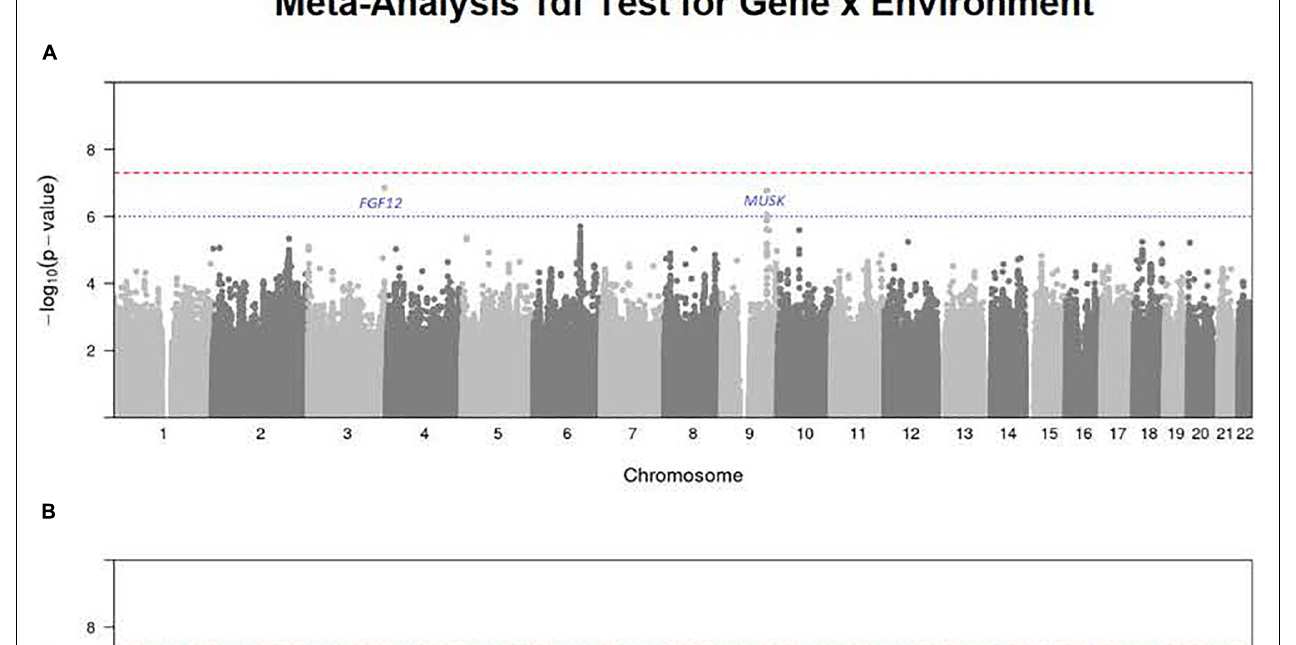
FIGURE 3 | Manhattan plots for the 1 df test for G × E interaction from meta-analysis over both GENEVA and POFC studies for (A) maternal smoking, (B) maternal alcohol consumption, and (C) maternal multivitamin supplementation. The red dashed line represents conventional critical value for genome-wide significance (5 × 10 − 8 ) and the blue dotted line represents a less stringent threshold (10 − 6 ) for “suggestive” evidence of G × E interaction.